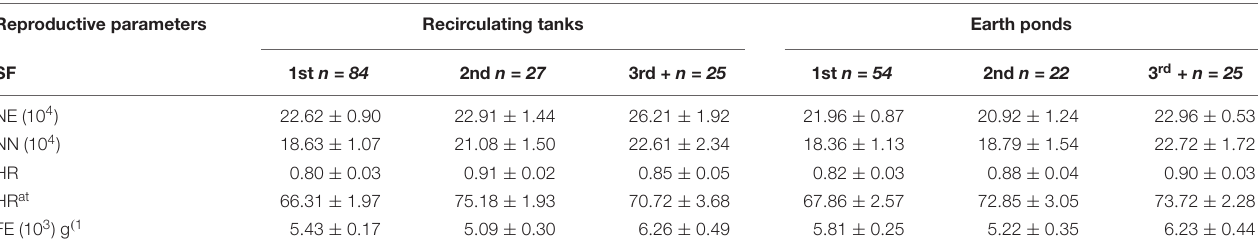
TABLE 3 | Comparison of mean reproductive parameters ( ± 1 SE) for different spawn order [the first spawns (1st), the second spawns (2nd), or the third spawns or more (3rd+)] for female broodstock reared in earthen ponds (EP) vs recirculating tanks (RT). Reproductive